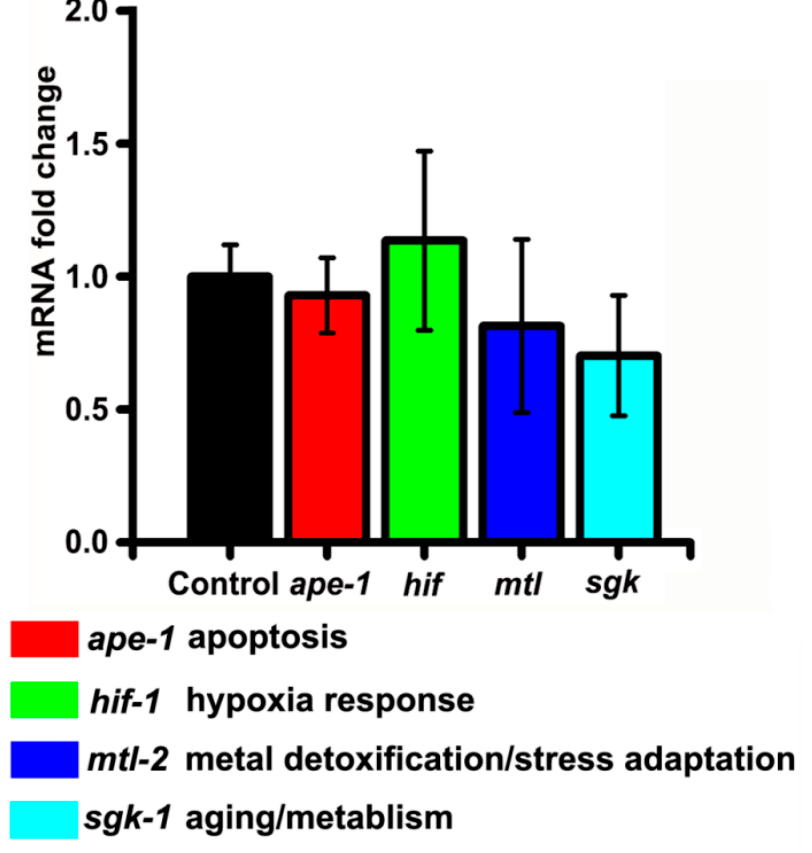
Figure 6. The relative expression levels of other different stress response genes in SiNP-treated C. elegans (three biological replicates, N ≥ 200/condition). The black column represents the normal- ized expression of the target genes in H 2 O-treated group. Error bars represent mean ± SEM. The statistical analysis indicated that no statistically significant differences in gene expression between the SiNP-treated groups and the H 2 O-treated groups were detected ( p >